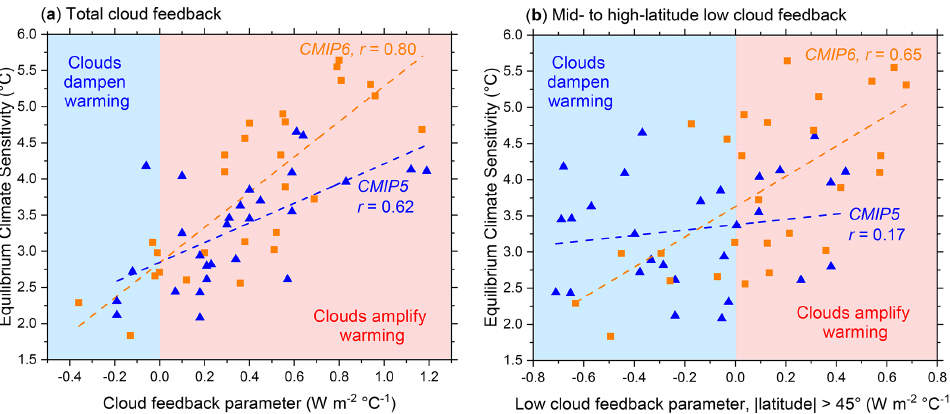
Figure 1. The equilibrium climate sensitivity plotted against cloud feedback parameter for CMIP5 and CMIP6 models. The left plot is for total cloud feedback parameter, while the right one is for shallow clouds ( < 680hPa) that are poleward of 45 ◦ . The data are from Zelinka et al. (2020). The correlation between low cloud feedback and ECS that has emerged in CMIP6 models indicates that the treatment of mixed-phase low clouds is critical for driving inter-model ECS